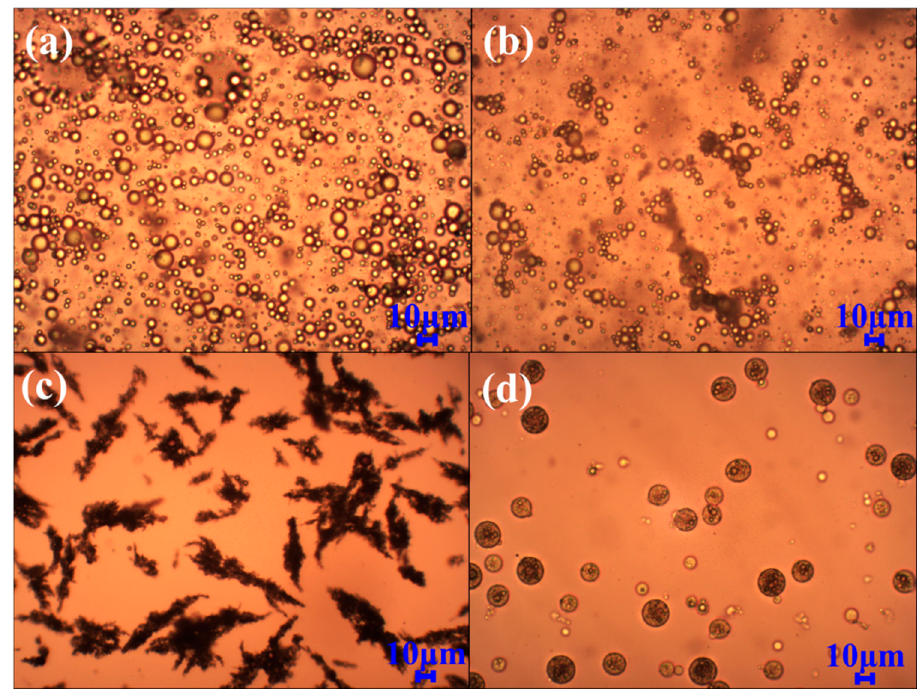
Figure 3. The picture of SC/GA by complex coacervation at different pH. ( a ) pH = 4.0, ( b ) pH = 3.5, ( c ) pH = 3.0, ( d ) pH = 2.5.